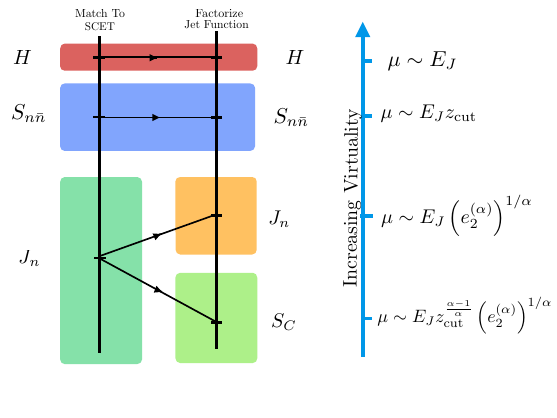
Figure 3. An illustration of the multistage matching procedure for the factorization of the soft dropped energy correlation function e ( (cid:11) ) . For simplicity, we have taken the soft drop angular 2 exponent, (cid:12) =